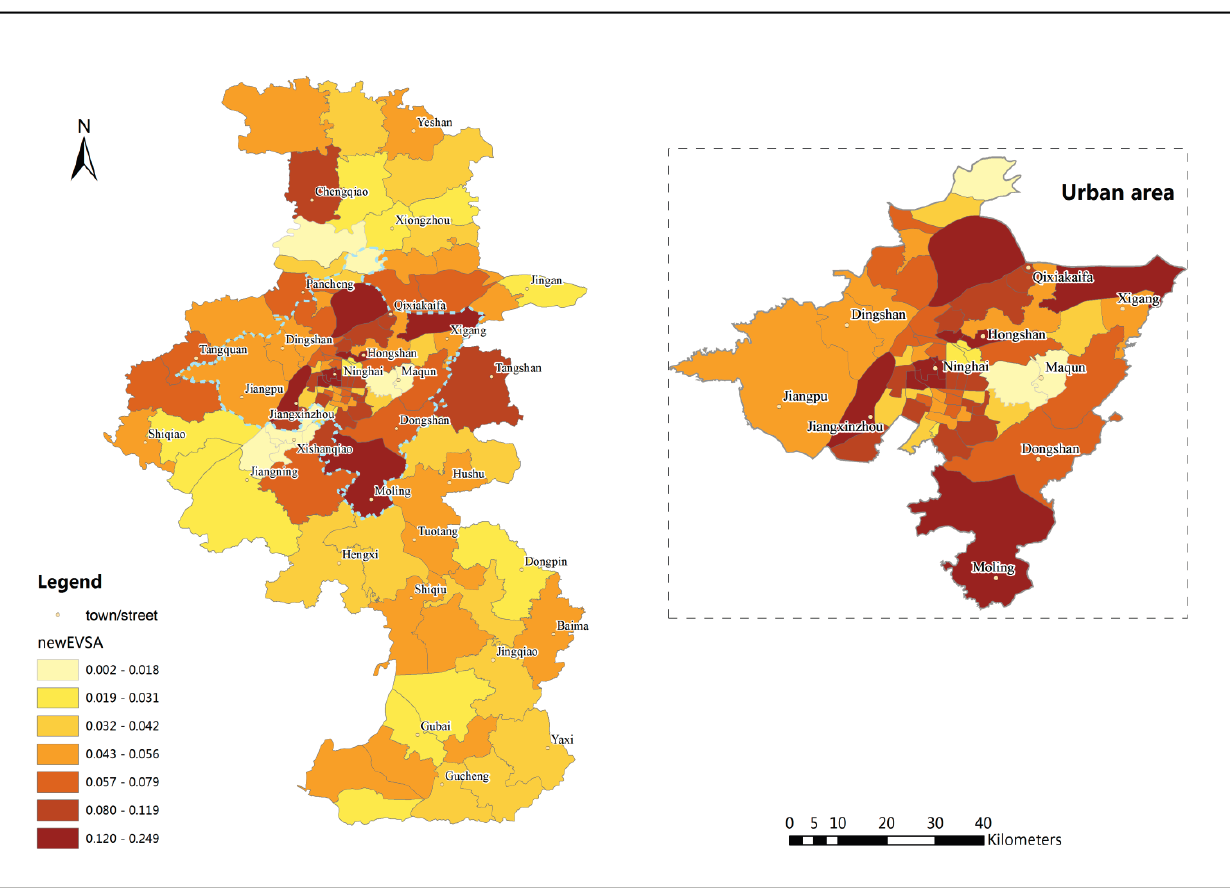
Figure 5. Spatial distribution of accessibility results using EV2SFCA